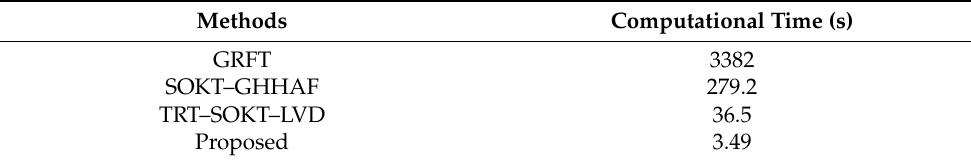
Table 3. Comparison of computational